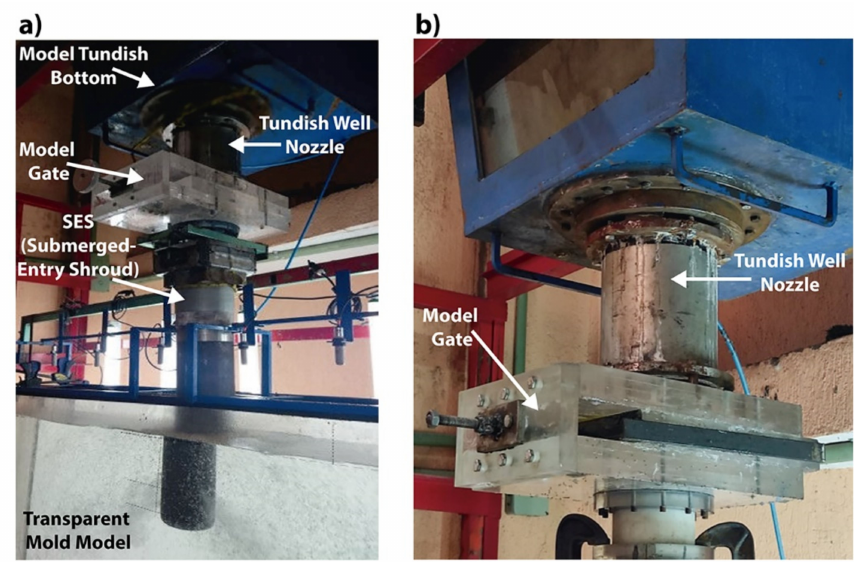
Figure 3. 1:1 scale water model. ( a ) General view of the mold with the level sensors. ( b ) Experimental Upper Tube Nozzle, UTN, and slide